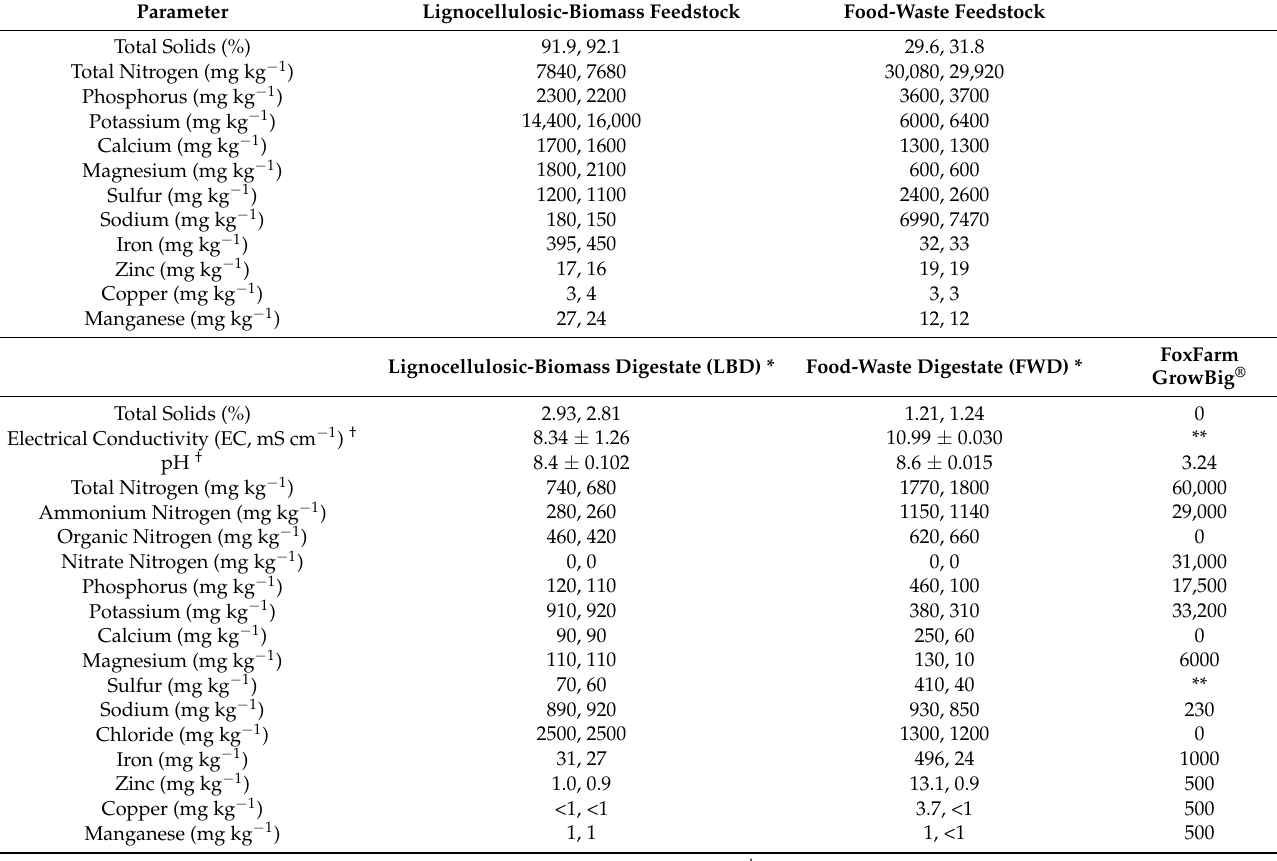
* Indicates full strength or concentrated form; ** indicates not measured; † n = 5 with error reported as standard